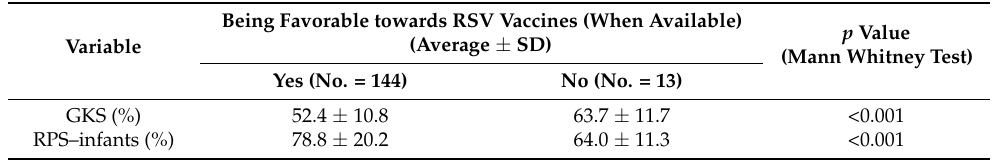
Table A3. Comparison of cumulative scores by being or not favorable towards RSV vaccines when available (Note: SD = Standard